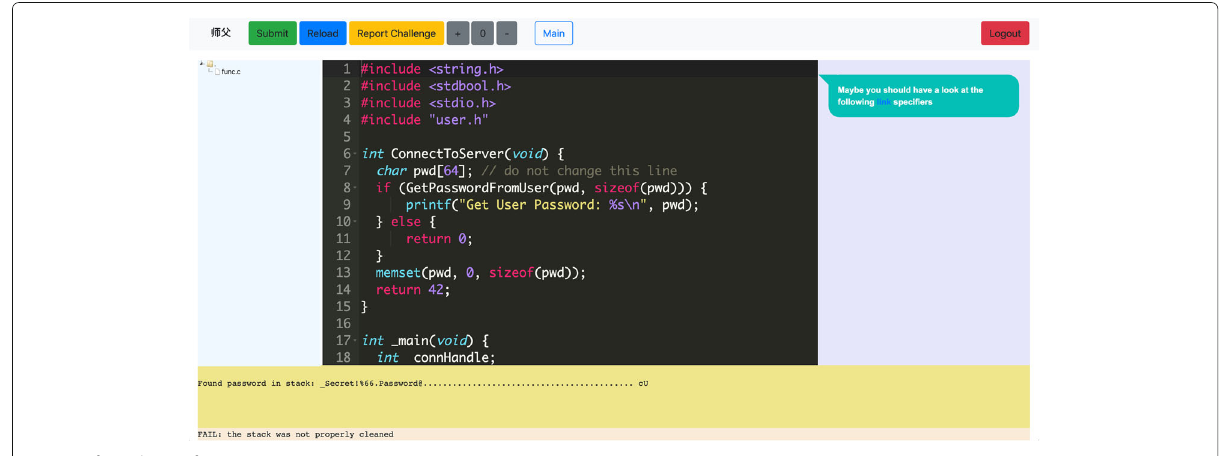
Fig. 8 Sifu Web Interface